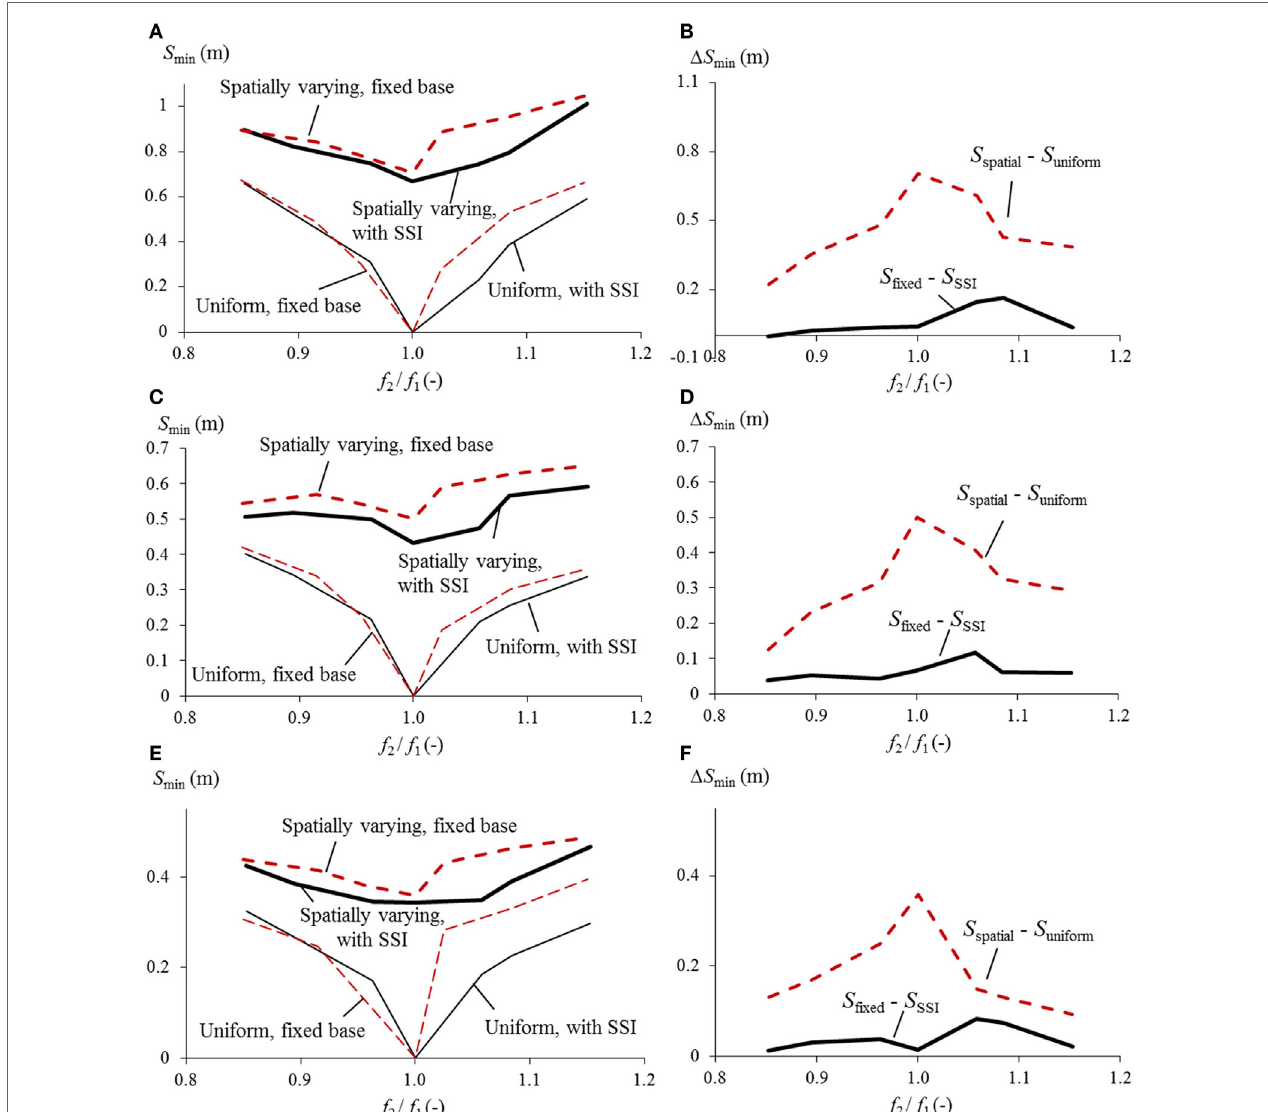
FigUre 12 | consequence of spatially varying ground motion and ssi for the minimum total gap between segments 1 and 2 due to excitations of (a,B) soft soil, (c,D) shallow soil, and (e,F) strong rock conditions, all with high correlation